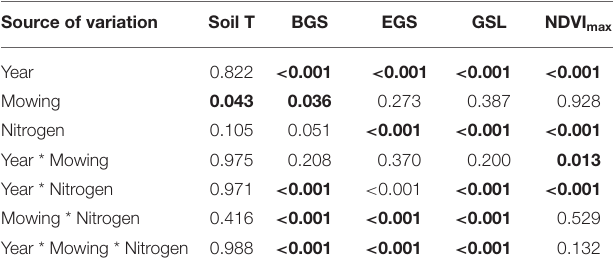
TABLE 1 | Results ( p -value) of three-way ANOVA on the effects of year, mowing, and nitrogen addition and their interactions on the soil temperature (Soil T), beginning (BGS), ending (EGS), and length of growing season (GSL), as well as the maximum of normalized difference vegetation index (NDVI max